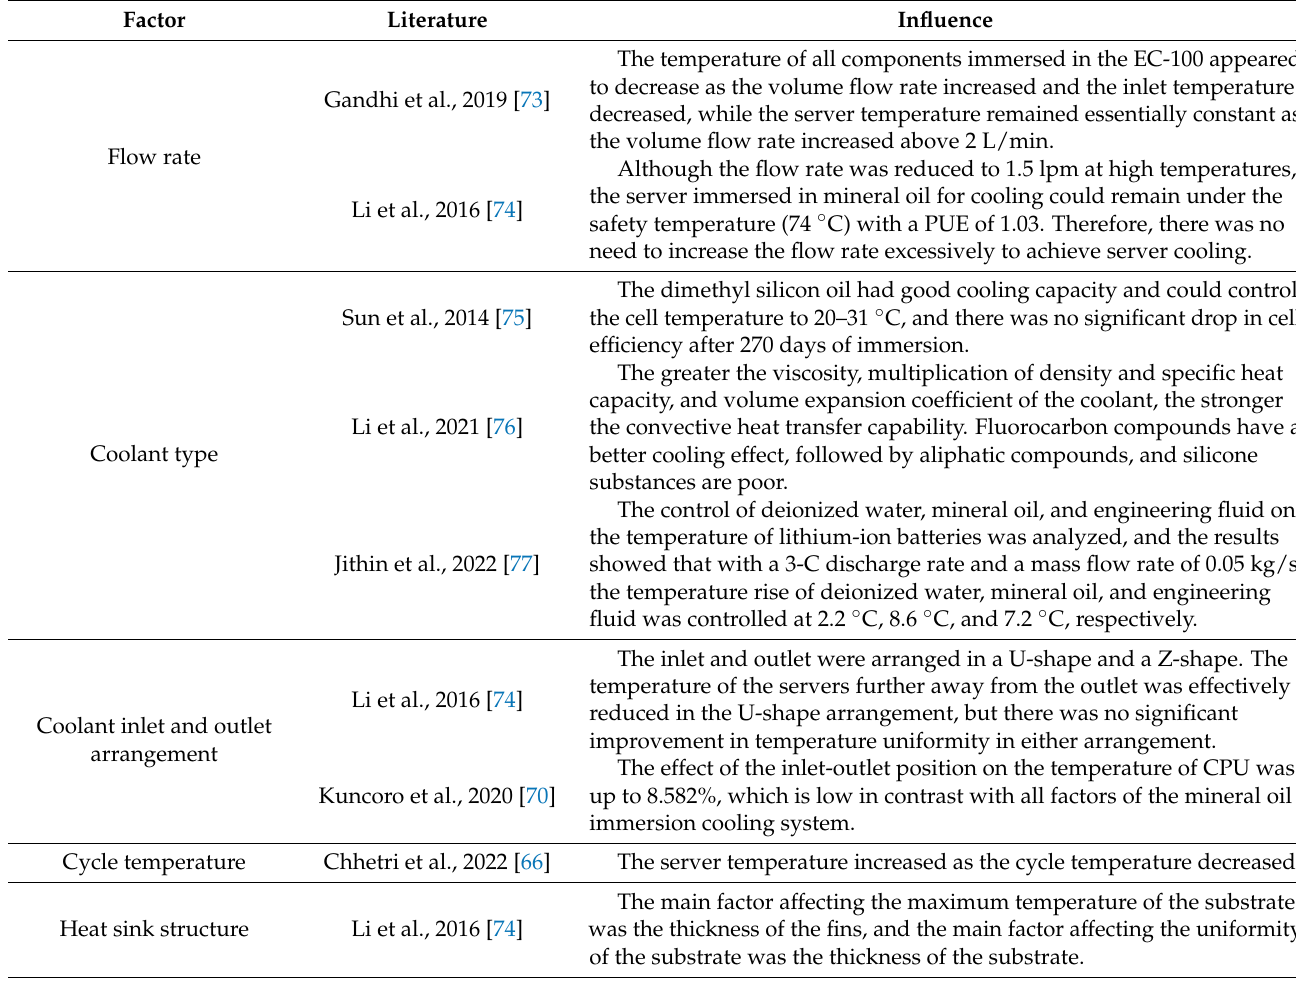
Table 3. Influences of factors on the refrigeration effect of single-phase immersion